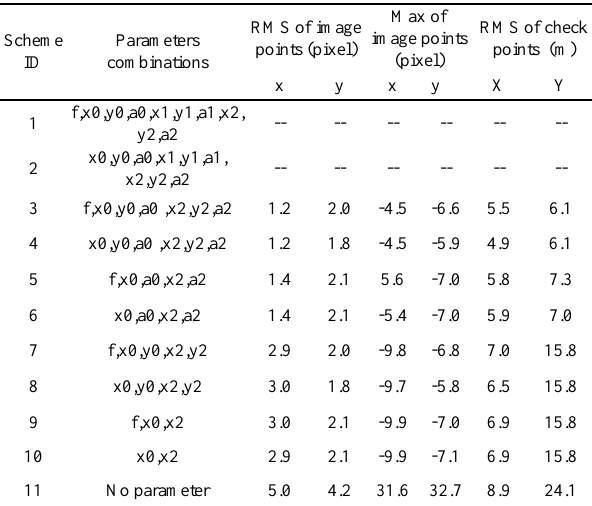
Table 3. Image point residues and check point planar precision with different schemes of IOPs combination